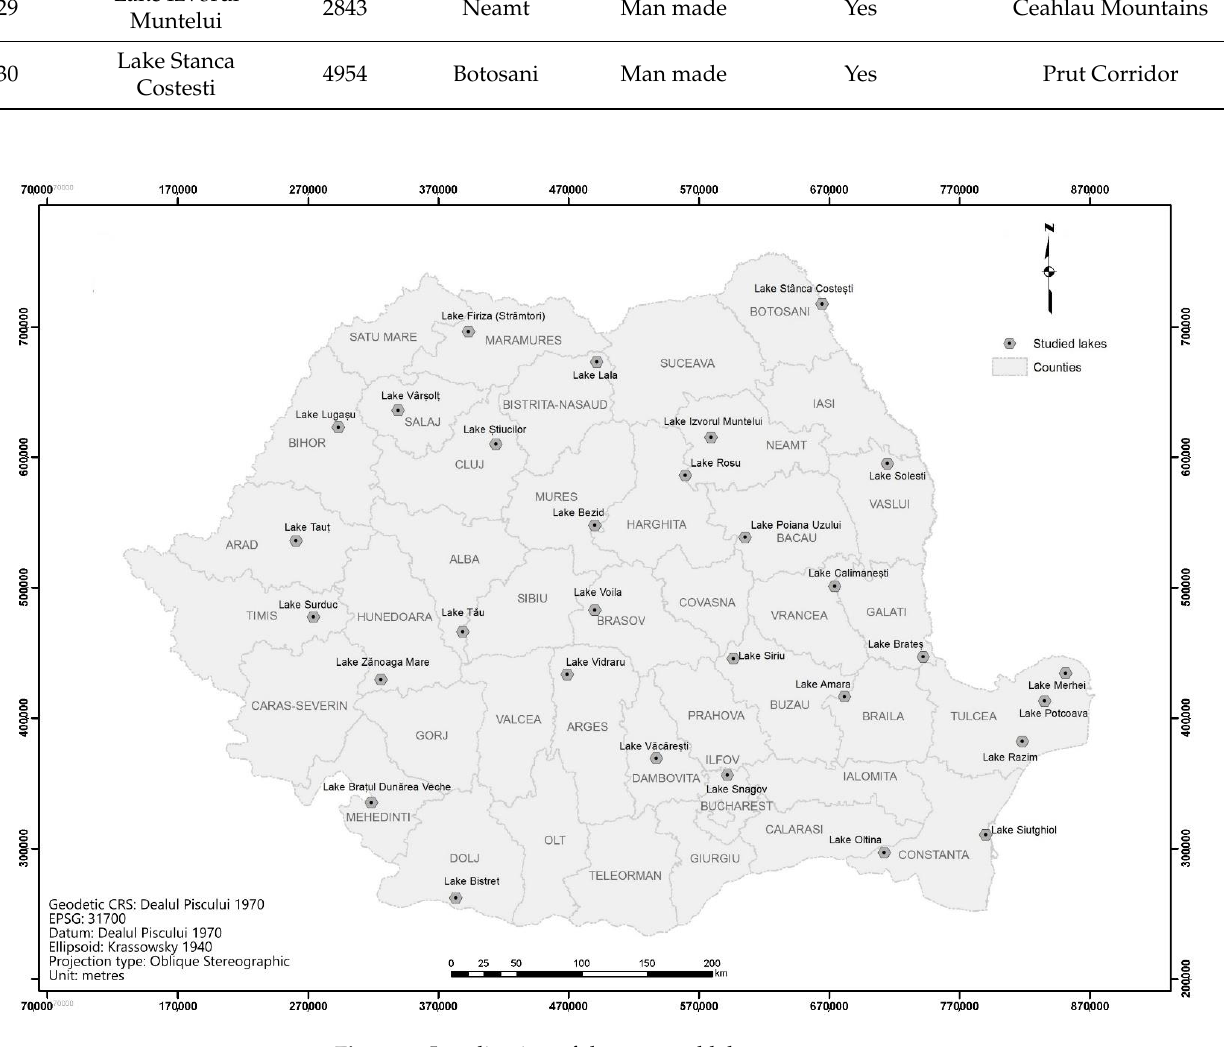
Figure 3. Localization of the assessed lake ecosystems.